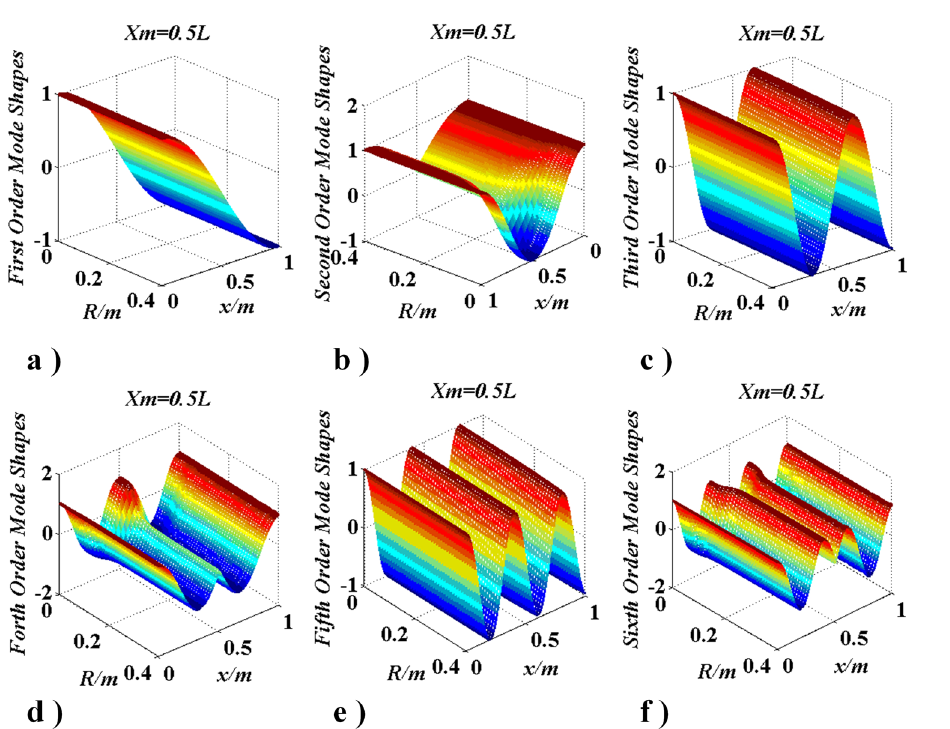
Figure 16. Curves of modes change with R ( J m ) and x m =